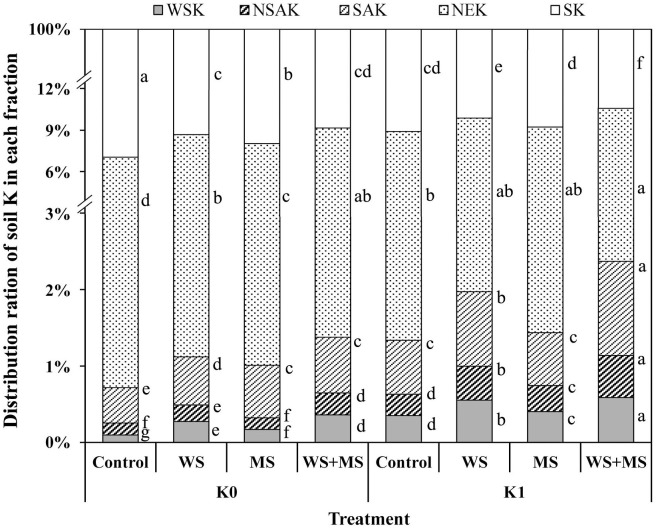
Effects of exogenous K addition on the distribution ratio (%) of soil K in different factions: Water-Soluble K (WSK), Non-Specific Adsorptive K (NSAK), Specific Adsorptive K (SAK), Non-Exchangeable K (NEK), and Structural K (SK) following a 60-d incubation.Control, no K addition; WS, wheat straw addition at 12 g straw·kg-1 dry soil; MS, maize straw addition at 12 g straw·kg-1 dry soil; WS+MS, wheat and maize straw addition, both at 12 g straw·kg-1 dry soil; K1, K fertilization at 200 mg K2O·kg-1 dry soil. All eight treatments were used to determine the effects on soil K fraction distribution ratios using one-way ANOVA. Different lower-case letters indicate a significant difference among the eight treatments in each K fraction (P<0.05).